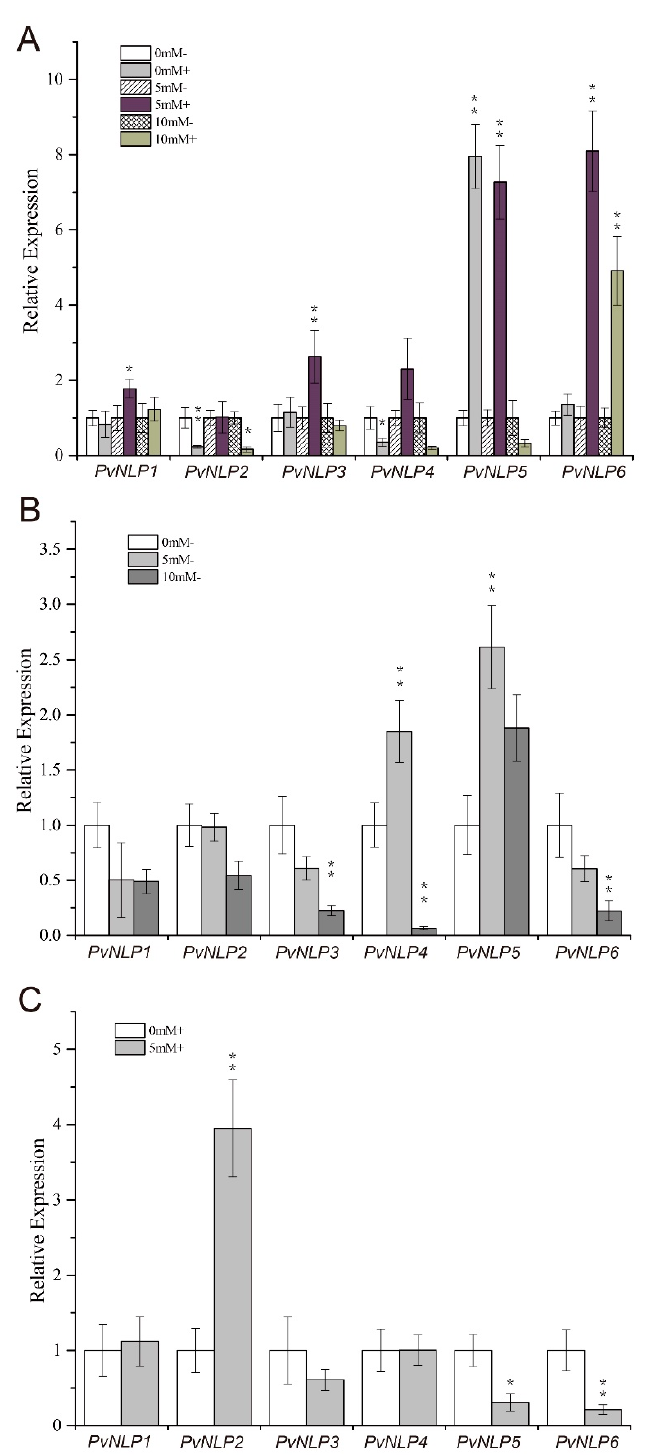
Figure 7. Expression analysis of selected PvNLP genes in early roots, early nodules, late roots, and nitrogen-fixing nodules (NFN) treated with di ff erent concentrations of nitrates. ( A ) Early roots and root-nodule mixtures treated with ( + ) or without (-) inoculation and 0 mM, 5 mM, or 10 mM KNO 3 . ( B ) Late roots treated without inoculation and 0 mM, 5 mM, or 10 mM KNO 3 . ( C ) NFN treated with inoculation and 0 mM or 5 mM. Student’s t -test was performed for two groups of inoculated and uninoculated samples under the same concentration of nitrogen (such as 0 mM- versus 0 mM + ) in A ; 0mM- versus 5 mM-, 0 mM- versus 10 mM- in B ; and 0 mM + versus 5 mM + in C , * p < 0.05, ** p < 0.01, *** p < 0.001.